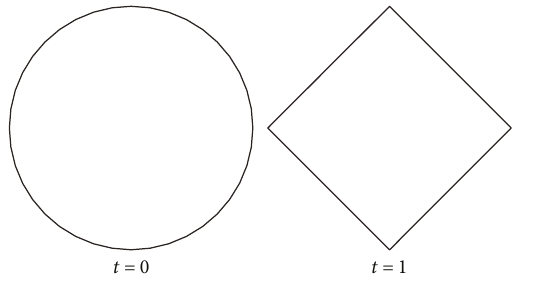
Figure 1: A circle and a diamond for the source and destination, respectively.